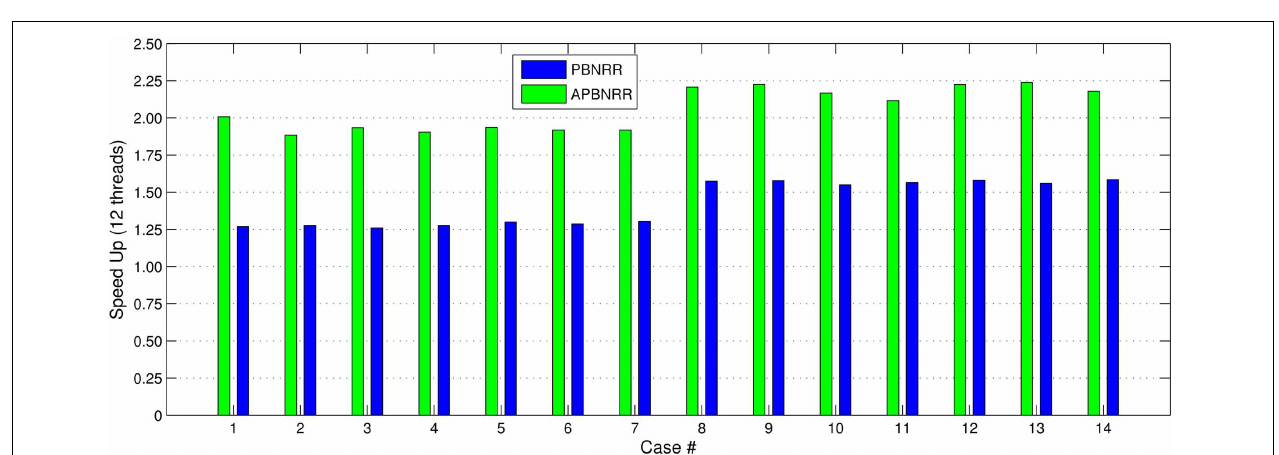
FIGURE 9 | The end-to-end speedup for the 14 clinical cases using 12 hardware cores.